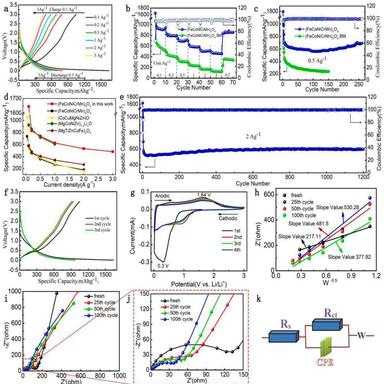
Electrochemical performance of (FeCoNiCrMn)3O4 HEO: (a) the first charge–discharge profiles of (FeCoNiCrMn)3O4 HEO from 0.1 to 3.0 A g− 1 ; (b, c) rate and cycle performances of (FeCoNiCrMn)3O4 HEO and (FeCoNiCrMn)3O4 BM; (d) the rate performance of (FeCoNiCrMn)3O4 HEO compared with other materials ((FeCoNiCrMn)3O4, (CoCuMgNiZn)O, (MgCoNiZn)1− xLixO, (MgTiZnCuFe)3O4); (e) cycling performance at 2 A g− 1 ; (f) The charge–discharge profiles of the first three cycles at 0.1 A g− 1 current density; (g) CV curve